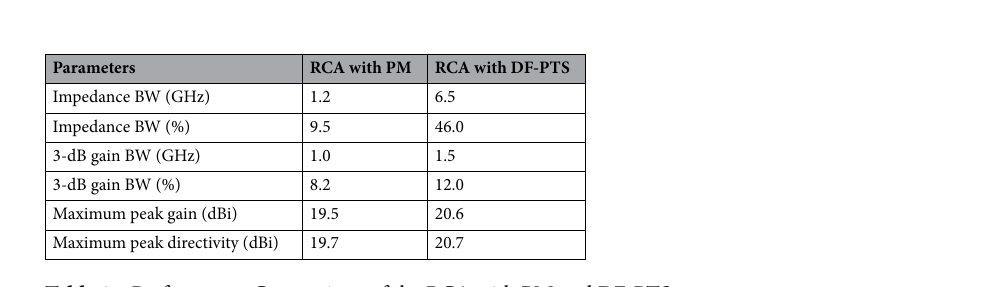
Table 2. Performance Comparison of the RCA with PM and DF-PTS.